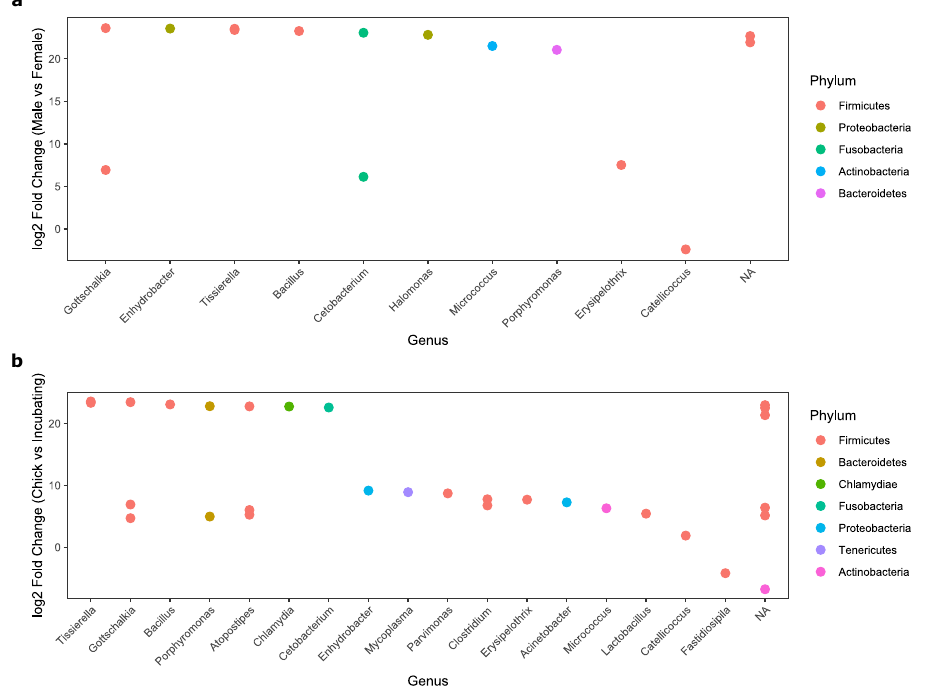
Figure 5. Differences in abundance of various ASVs in the murre microbiome between sexes ( a ) and reproductive stages ( b ). Each point represents an ASV from a particular class that is more or less abundant in one group than the other. Colors represent the different phyla these ASVs belong